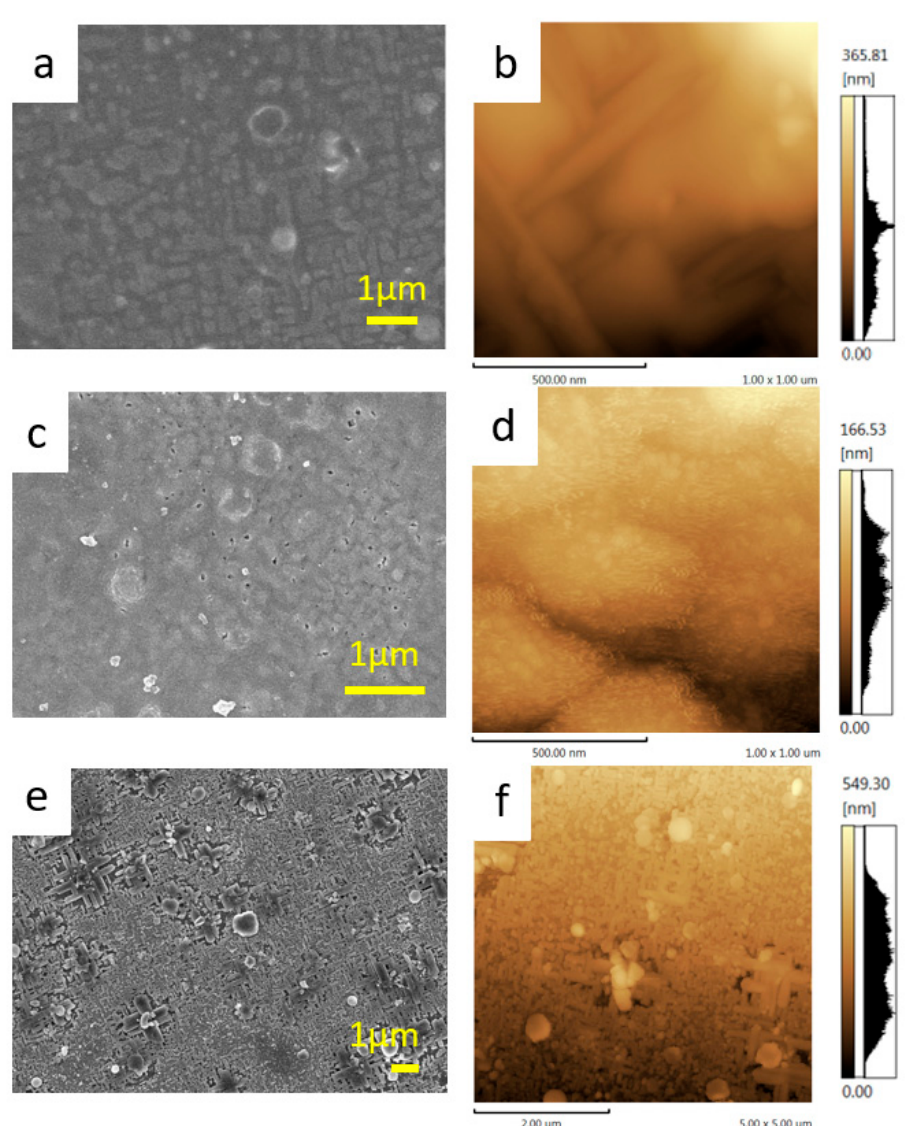
Figure 4. SEM ( a , c , e ) and AFM ( b , d , f ) images of thin films. As-deposited MgB 2 film without ion- exchange treatment ( a , b ), ion-exchanged film treated with resin for 3 days ( c,d ), and ion-exchanged film treated with formic acid for 2 days ( e , f ).